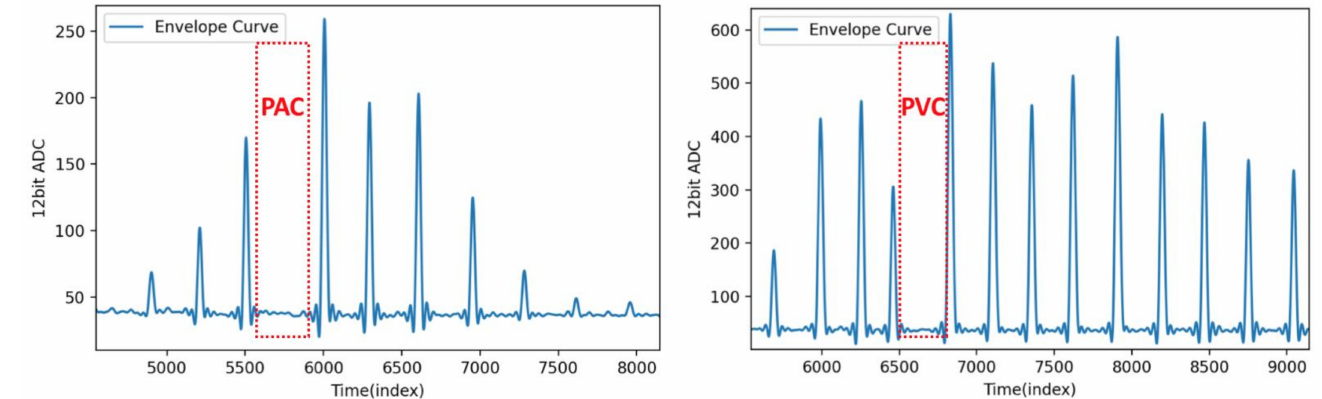
Figure 16. The oscillometric envelope waveform of a PAC/PVC